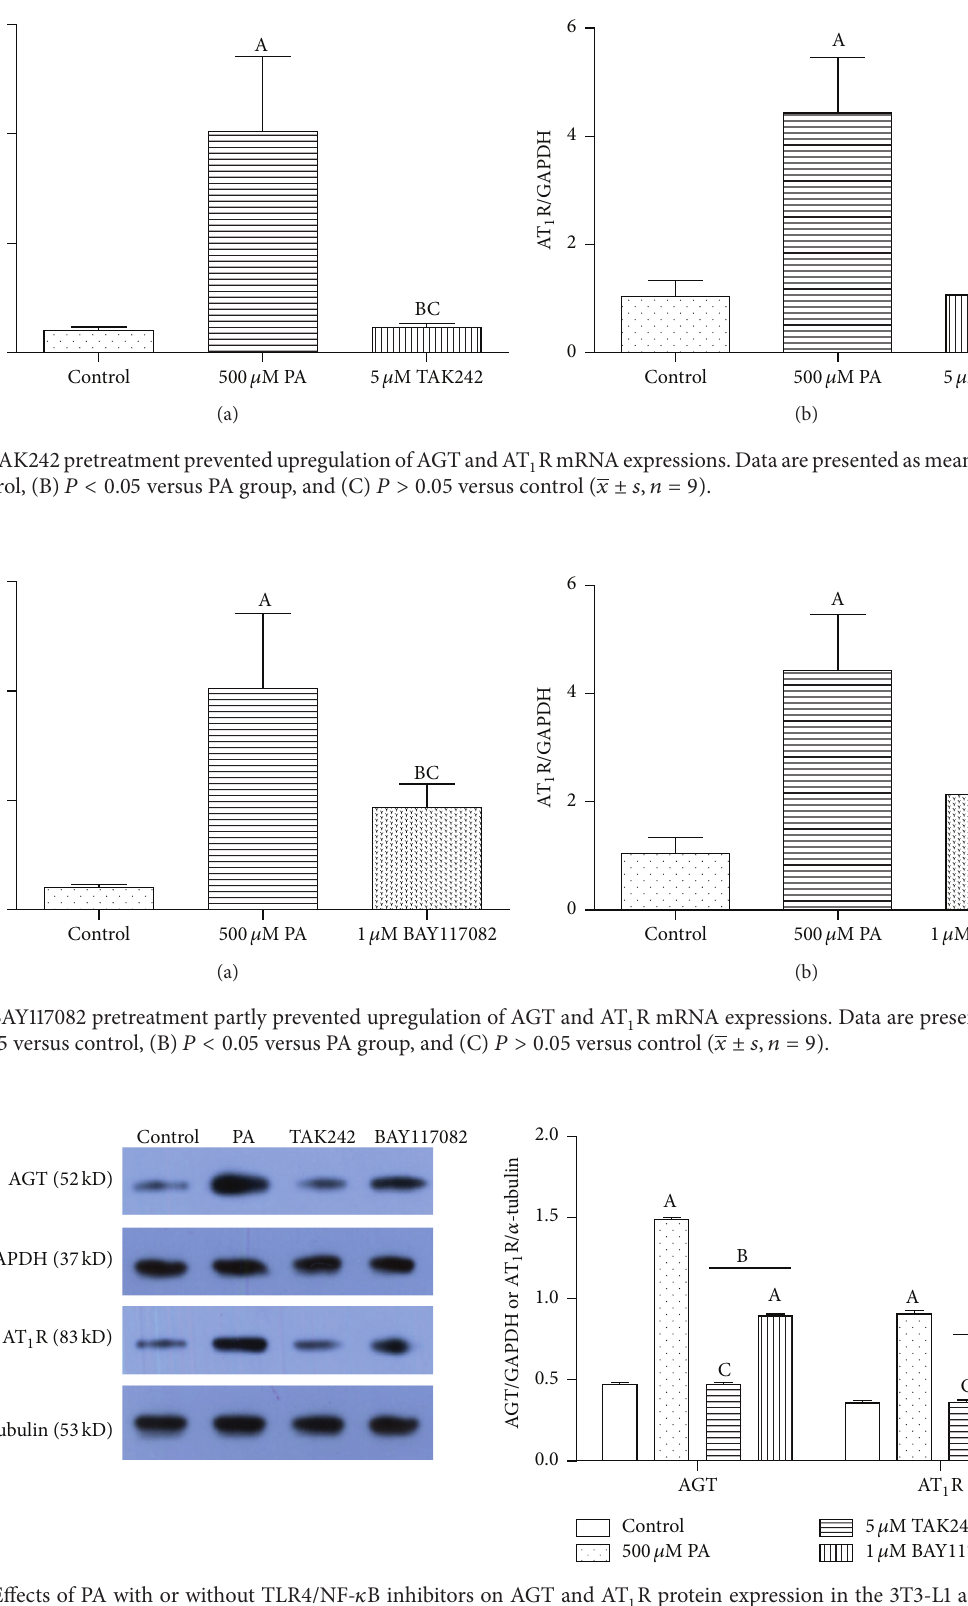
Figure 6: Effects of PA with or without TLR4/NF- 𝜅 B inhibitors on AGT and AT 1 R protein expression in the 3T3-L1 adipocytes. Data are presented as mean ± SD. (A) 𝑃 < 0.05 versus control, (B) 𝑃 < 0.05 versus 500 𝜇 M PA, and (C) 𝑃 > 0.05 versus control ( 𝑥 ± 𝑠 , 𝑛 = 3